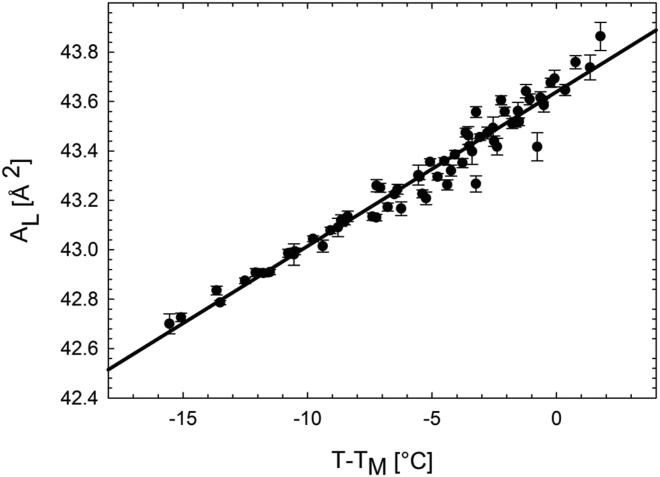
Gel area-per-lipid (AL) calibration curve determined from WAXS. Data on an absolute temperature scale are shown in Fig. S8.